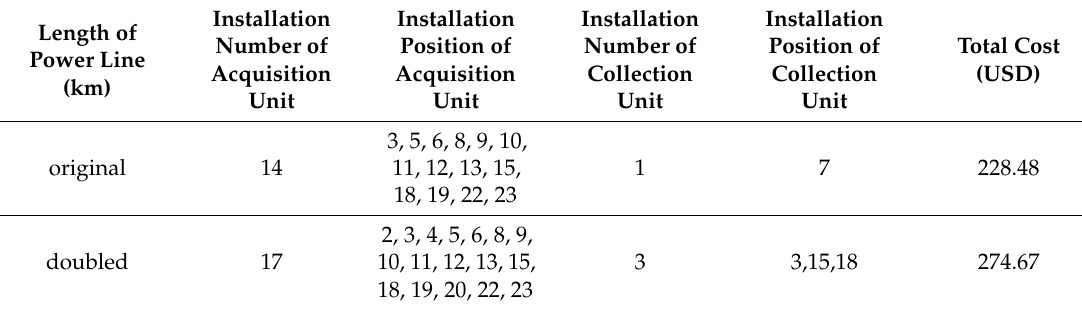
Table 4. Optimal placement of fault indicators under di ff erent power line